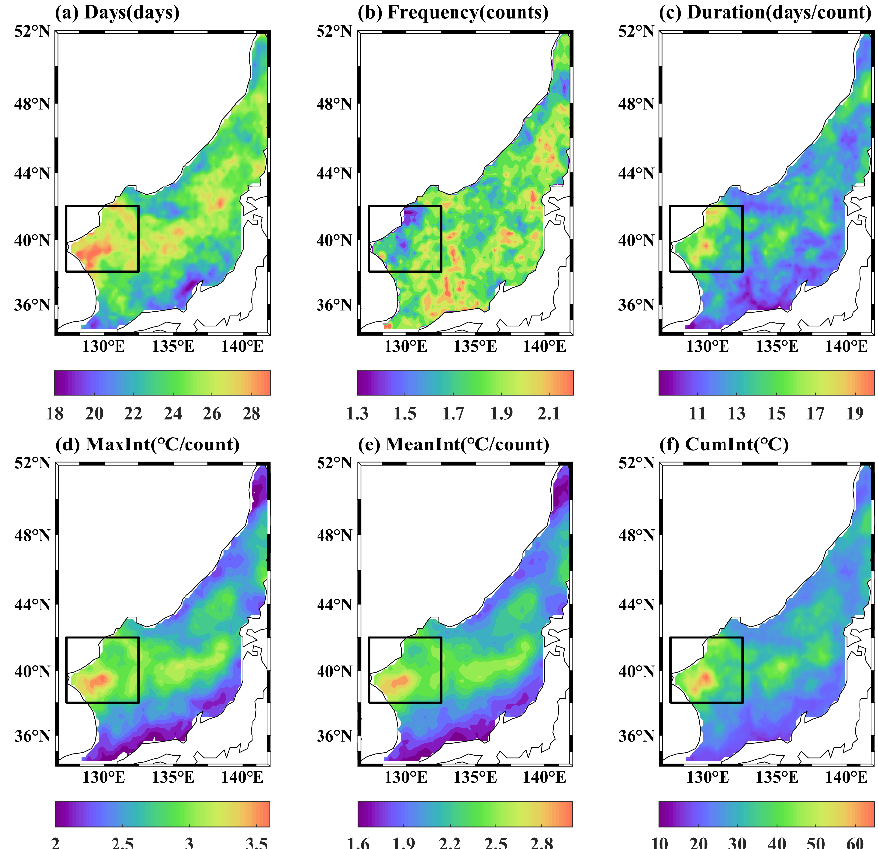
Figure 2. Spatial distributions of 40-year average during 1982–2021 all year: ( a ) total MHW days, ( b ) frequency, ( c ) duration, ( d ) MaxInt, ( e ) MeanInt, and ( f ) CumInt in the JES. The black box indicates the study area.